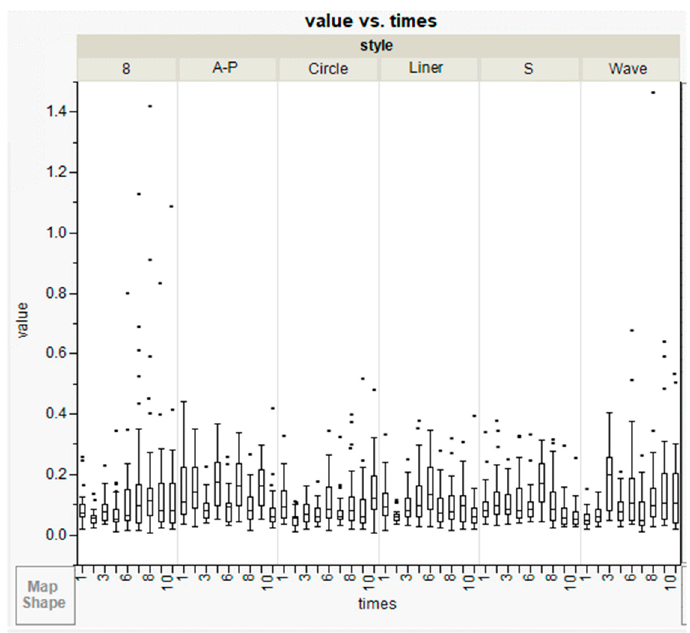
Figure 8. The box plot shows the repetitive deviation of the six head movements in 10 scans. The 8-figure movement showed poor precision among six movements in the maxilla.